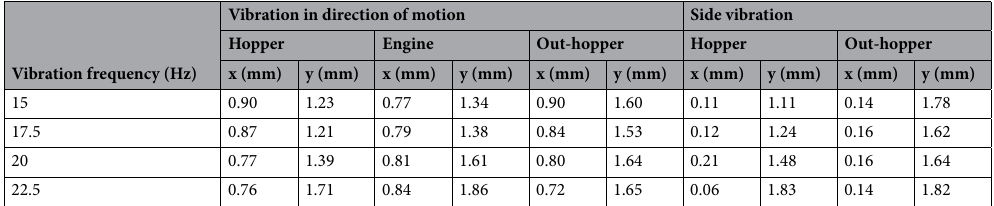
Table 2. Vibration size of the x and y validation vibrating feeder.